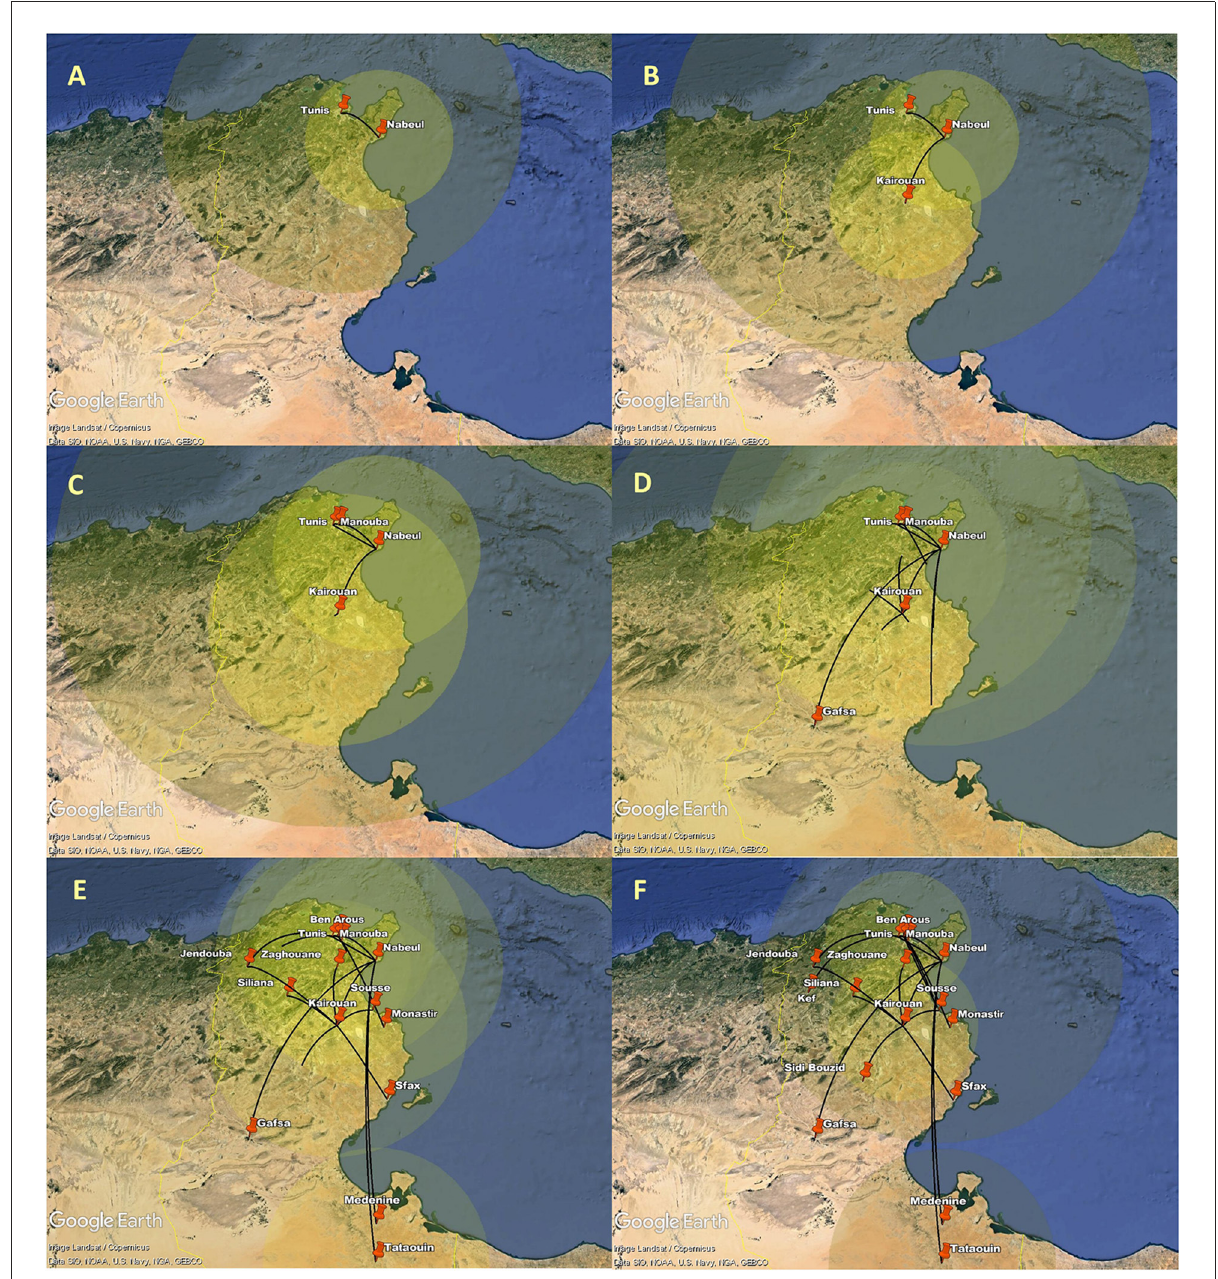
FIGURE7 Spatial dynamics of AY.122 Delta variant of SARS-CoV-2 among different Tunisian governorates. The snapshots (A–F) show the different stages of AY.122 variant spread in Tunisian governorates. Transition lines linking different locations represent the branches in the MCC. Diameters of the circles are proportional to square root of the number of MCC branches maintaining a particular location state at each time point.